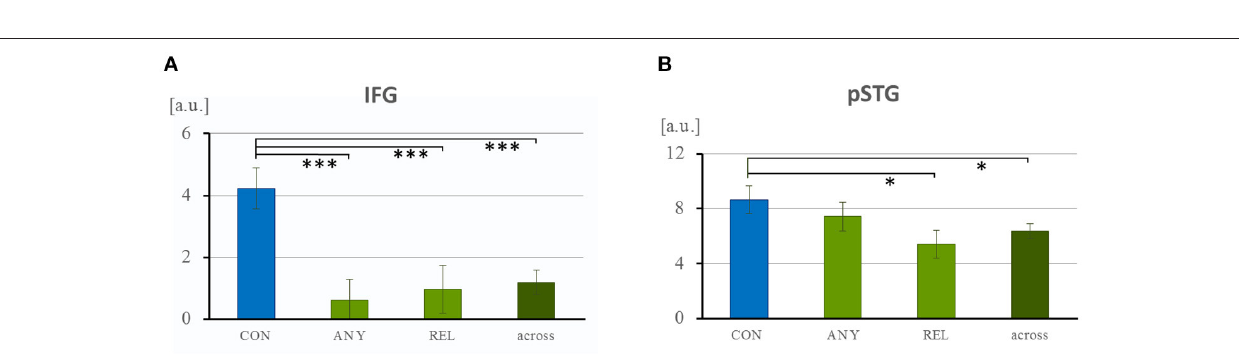
FIGURE 6 | Exploratory whole brain maps for task-comparisons. Exploratory t-maps (p uncorr < 0.001; cluster threshold: 10 voxels) compared each pair between the three tasks, which resulted in six contrast maps. Of those, only the two contrasts “CON > ANY” (A) and “CON > REL” (B) revealed clusters above threshold. Both maps confirmed the specific contribution of the IFG to the conventionality task (CON). Additionally, compared to the REL task (gesture-speech relation), the CON task increased covariance in the mFG, bilateral MTG, right IFG and right cuneus. IFG PTr, Inferior frontal gyrus, pars triangularis; mFG, medial frontal gyrus; MTG, middle temporal gyrus.